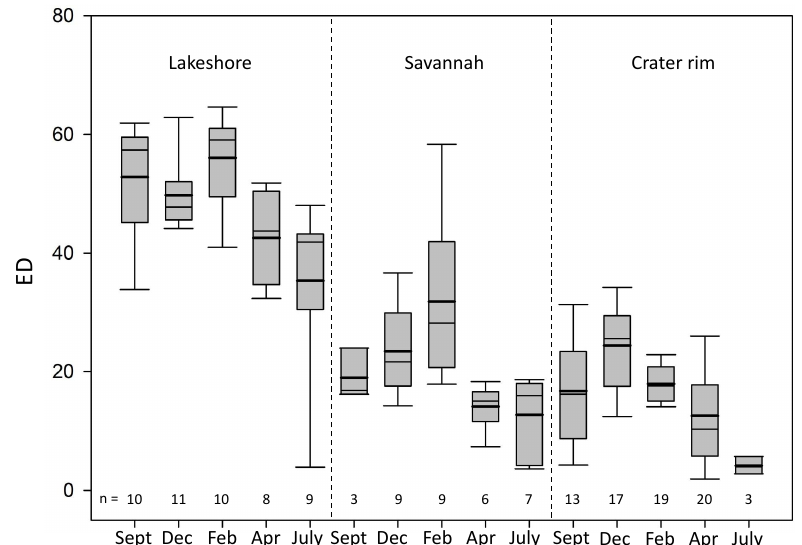
Figure 5. The evaporation distance (ED) of xylem samples, describing the relative degree of evaporation by calculating the distance from the LMWL along an evaporation line, among habitats and seasons. n : amount of